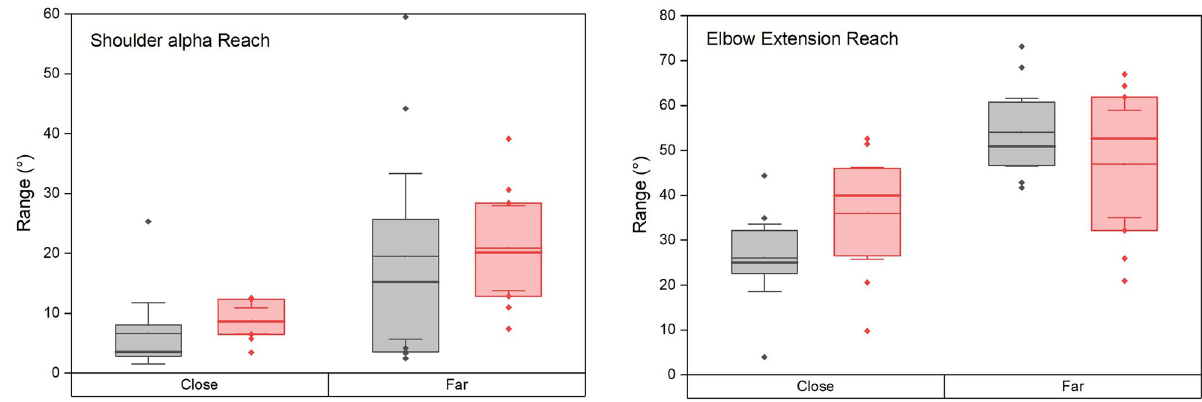
Fig 5. Amount of shoulder and elbow rotations during reaching phases, same legend as Fig 4. The thick horizontal line indicates the median and the thin one the mean.